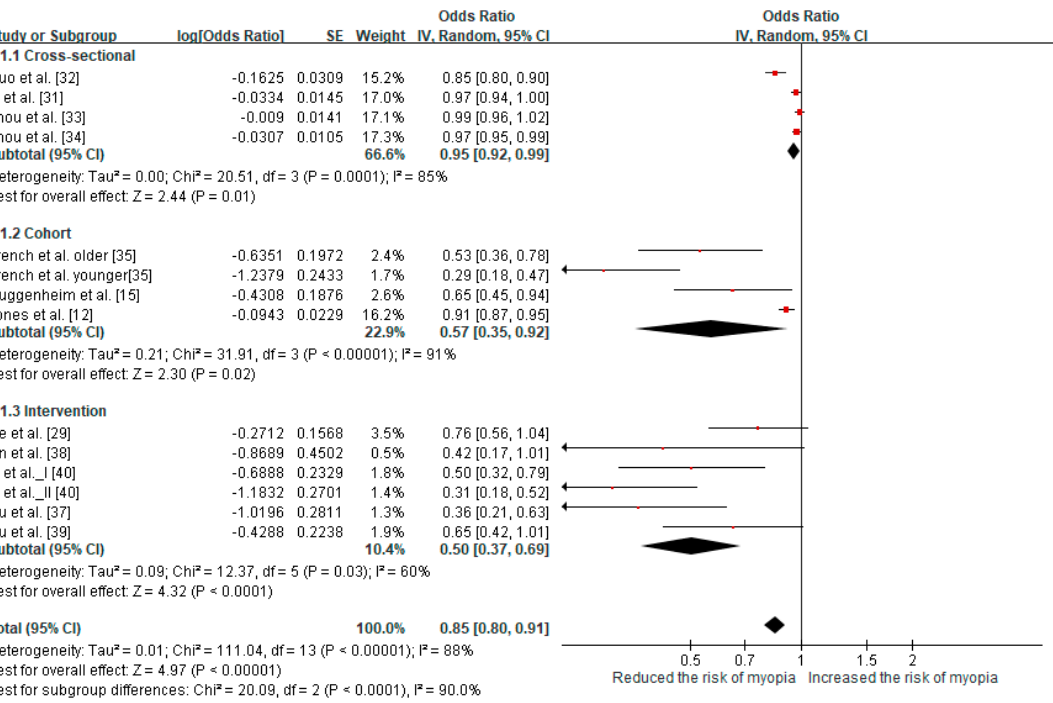
Figure 2. Results of the meta-analysis for myopia incidence and prevalence.